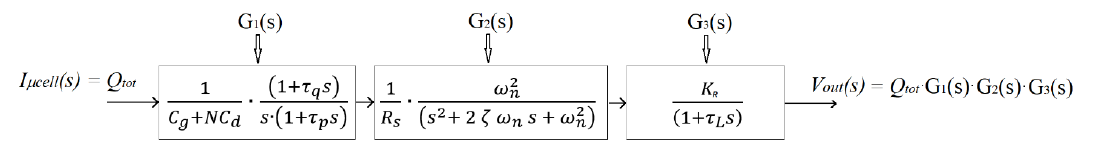
Table 1. Electrical parameters of the SiPM used in the simulations.